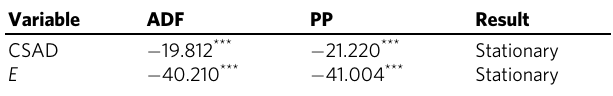
Table 1 Results of unit root